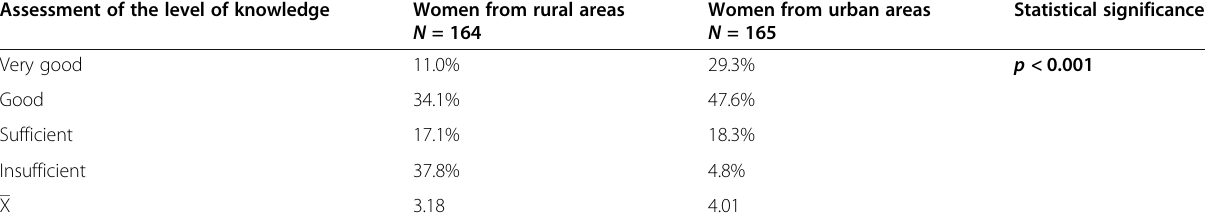
Table 3 Assessment of the level of knowledge of the respondents according to their place of residence Assessment of the level of knowledge